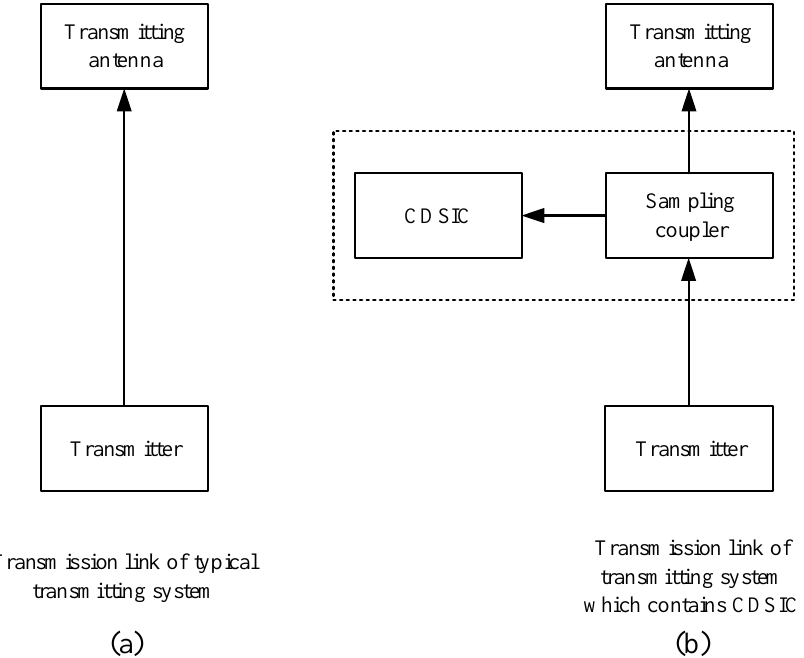
Figure 12. Typical transmitting system and transmitting system containing a CDSIC.